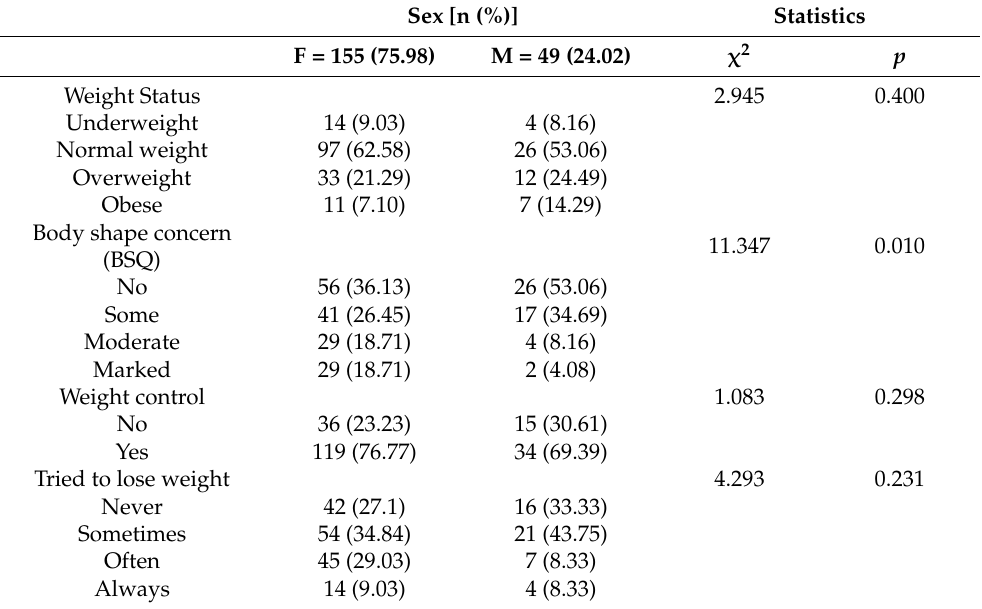
Figure 1. Sample flowchart. Table 1. Frequencies of weight status, body shape concern, weight control and trying to lose weight by